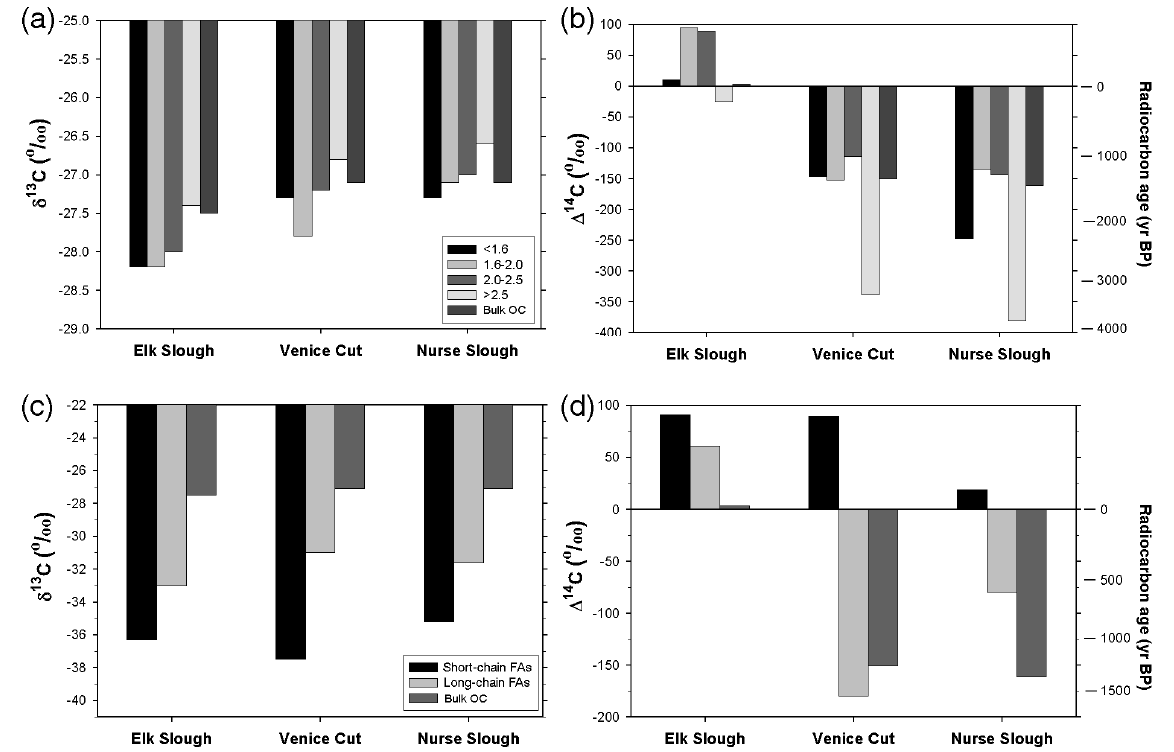
Figure 5. δ 13 C (a) and (cid:49) 14 C (b) values for OC in Delta bulk sediment and density fractions and δ 13 C (c) and (cid:49) 14 C (d) values for fatty acids in bulk